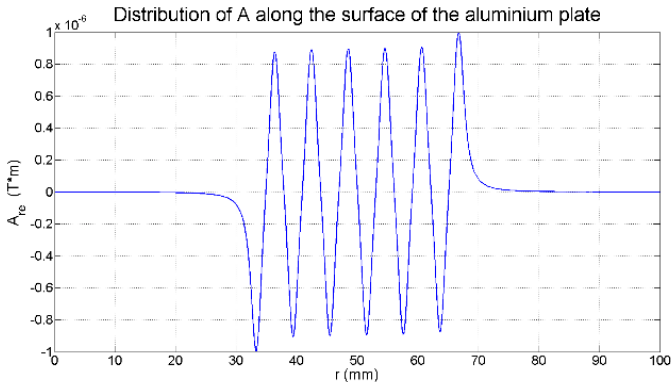
Figure 4. For a meander-line-coil, the distribution of the vector potential A at z = 0. Reproduced with permission from [15], IEEE, 2016.